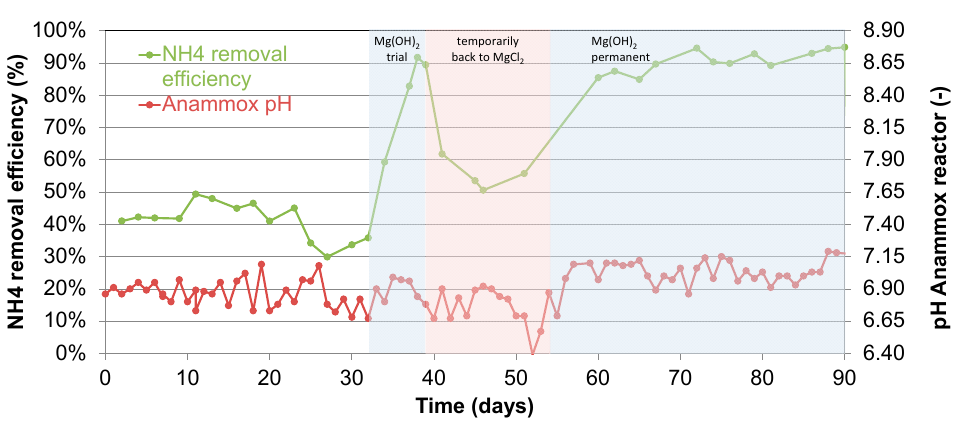
Figure 13. Operational data from the ANAMMOX reactor downstream of a struvite precipitation reactor. The shaded areas refer to periods in which changes were made in the use of magnesium source in the struvite reactor. Average influent NH 4 in the presented period was 621 ± 45 mg NH 4 -N/L.